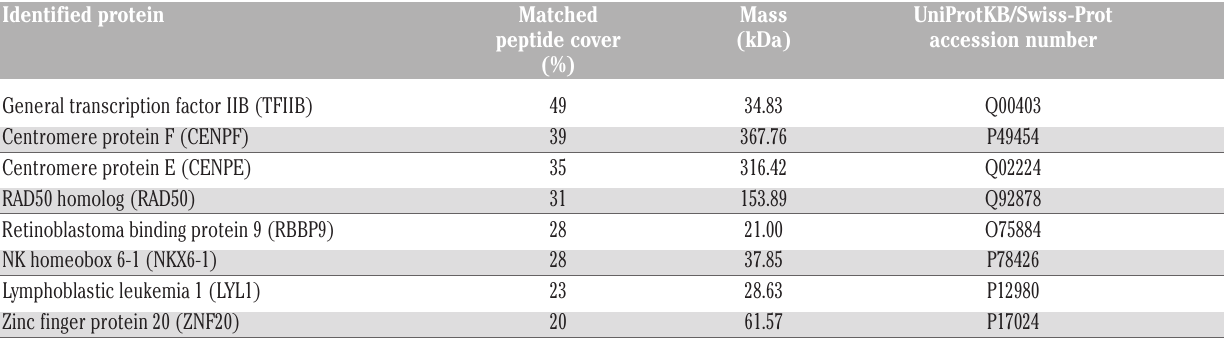
Figure 6. TLX1 interacts with TFIIB. (A) Isolation of TLX1-associated pro- teins. Nuclear extracts from ALL-SIL leukemic T cells were immunoprecip- itated using TLX1-specific antibody (Ab), or no antibody (No Ab) as neg- ative control. Coprecipitated proteins were resolved by SDS-PAGE and sil- ver stained. (B) GST pulldown assay. GST, GST-TLX1 and GST-TLX1 Δ H3 immobilized on glutathione-Sepha - rose beads were incubated with in vitro-translated, 35 S-labeled TLX1 as positive control, and TFIIB. Bound proteins were washed, eluted, resolved by 12% SDS-PAGE and detected by autoradiography: 50% of the labeled input proteins TLX1 and TFIIB are shown on the